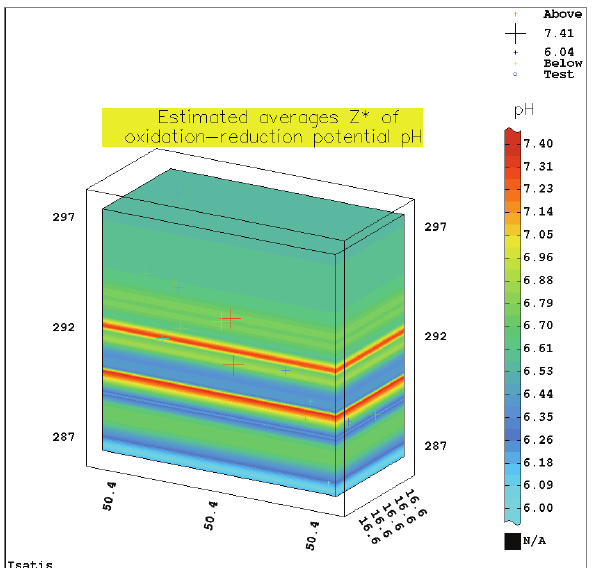
Fig. 28. Block diagram of estimated averages Z * distribution of oxidation-reduction potential pH in underground water in Kłodzko intake area; 14 wells + 3